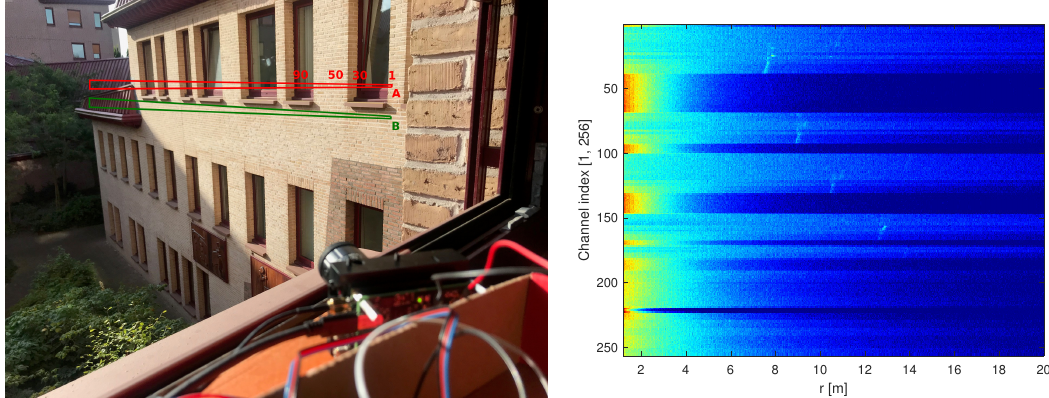
Figure 1. (a) Outdoor measurement setup. The laser stripe (approx. 0.3°x 37°) covers bright and darker areas of the wall. Its approximate shapes for two separate measurements are drawn with a red line (measurement A during sunlight) and with green line (measurement B during overcast). (b) Detection of sunlight illuminated targets is impossible (measurement A), because SPADs are flooded with background illumination photons, which trigger early detection immediately when the SPADs are ready for reception (shown with red color, e.g. near channel 50). Shaded surfaces are also almost undetectable (e.g. see the cyan patterns near channels 30 and 90, at 8 to 12 m